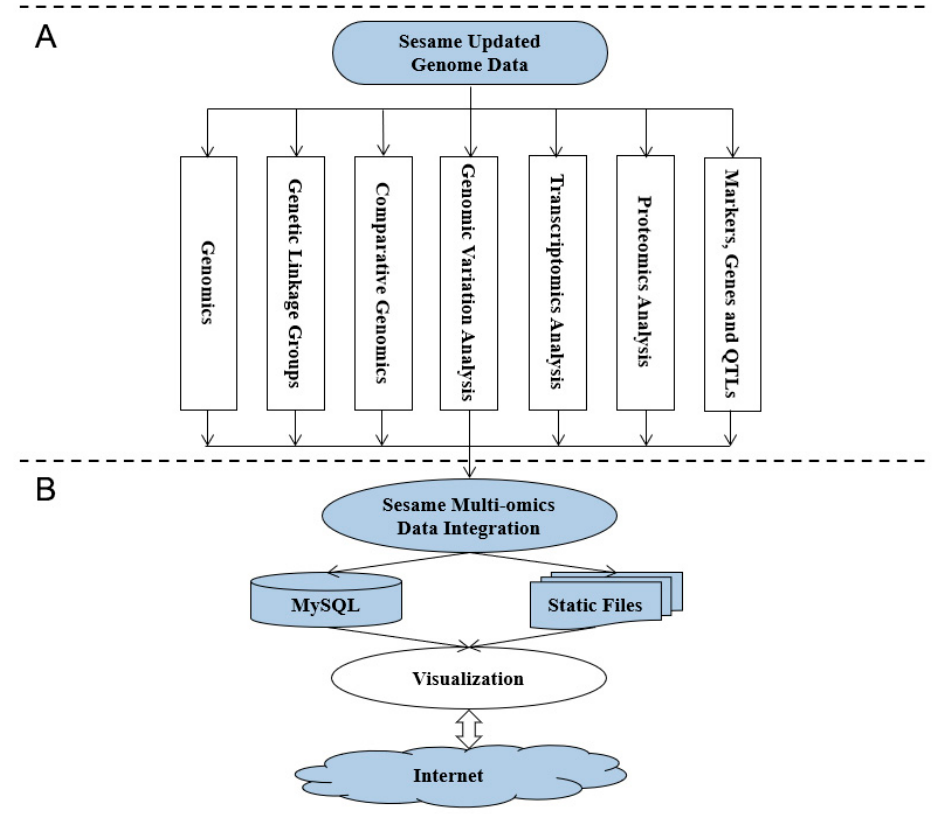
Figure 1. Framework for data integration and database implementation. ( A ) Data integration for sesame multi-omics data including the data of genomics; transcriptomics; proteomics; and functional markers, genes and QTLs. ( B ) Implementation of Sinbase 2.0 including data integration, data storage and visualization.